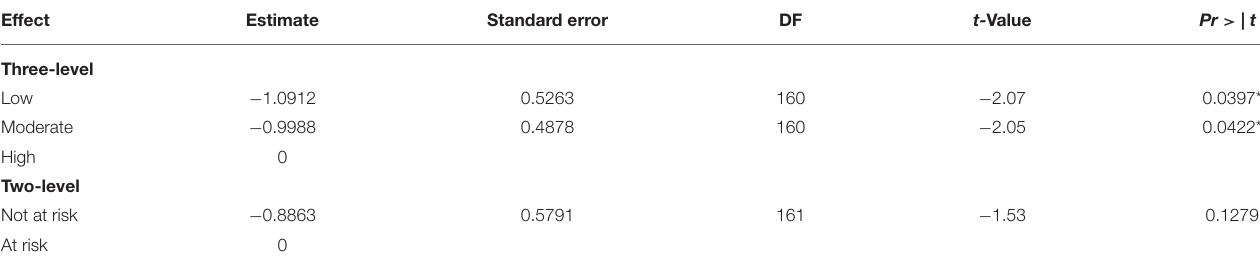
TABLE 3 | Generalized linear model estimates for prediction of daily fall risk by the two- and three-level Quick-STEADI algorithm, adjusting for age, sex, and